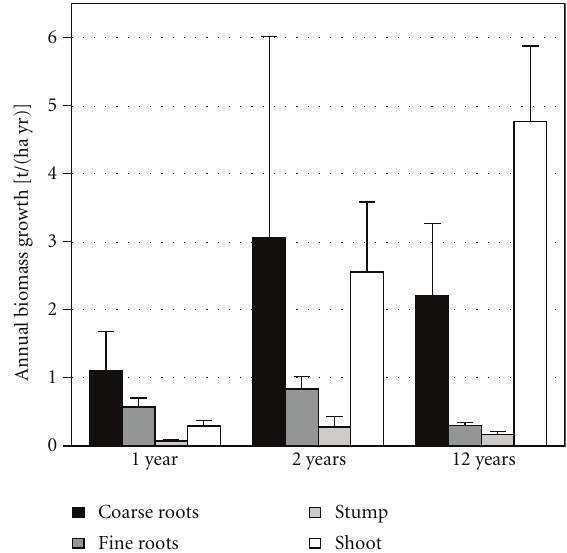
Figure 3: Plot of the average annual growth of the woody biomass compartments shoot , stump , fine roots, and coarse roots of a one-, two-, and a twelve-year-old stand of black locust ( Robinia pseudoacacia ).